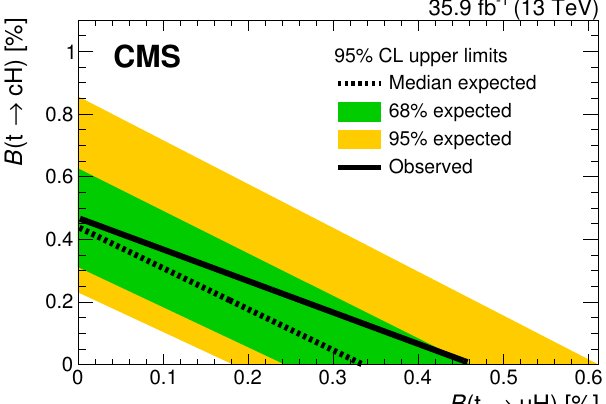
Figure 6 . Upper limits on B (t ! uH) and B (t ! cH) at 95% CL.